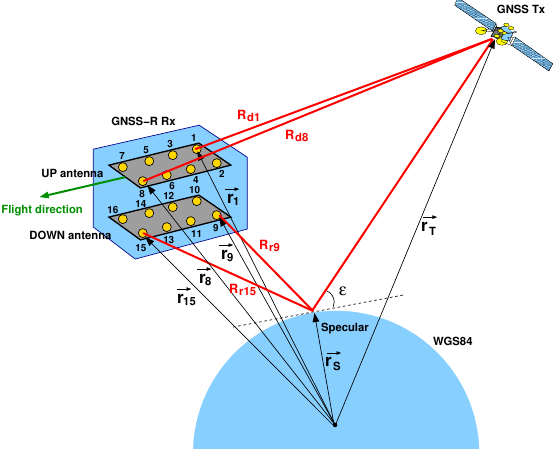
Figure 8. Scheme of the beamformer theoretical method. This example shows the different components involved in the computation of the beamformer phases for elements eight and 15 (where one and nine are the reference ones) in the up- and down-looking arrays, respectively. The distribution of the antenna elements is displayed as in the real